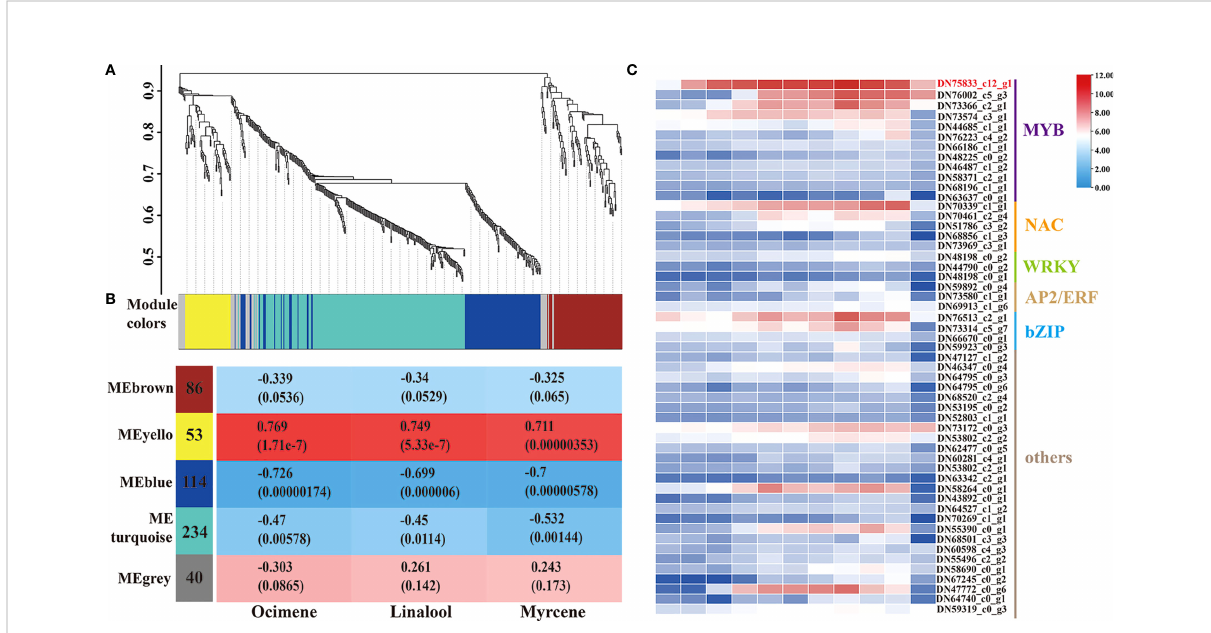
FIGURE 3 All TFs related to the three main fragrance compounds were identi fi ed by WGCNA. (A) Dendrogram plot with color annotation. (B) Nodule- monoterpenes weight correlations and corresponding P -values. (C) Heat-map comparison and TF categories in the MEyellow module. The change in the bar color from blue to red indicates a change in expression from low to